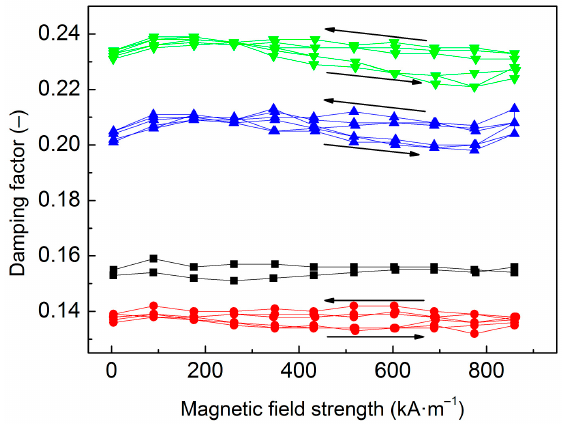
Figure 10. Damping factor, tan δ , of neat PDMS matrix ( black squares ), and the MREs containing bare CI ( red circles ), CI- g -PHEMATMS-1 ( blue up-triangles ), and CI- g -PHEMATMS-2 ( green down- triangles ) particles as a function of applied magnetic field